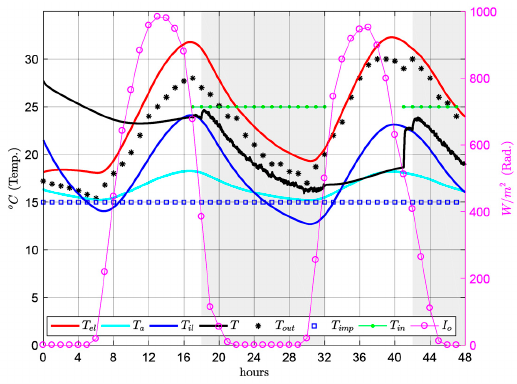
Figure 7. Case 1: Le Corbusier hypothesis. Summer. Data: calculated temperatures: T el , T a , T il , T at a height of 1.5m, outdoor temperature T out , impulse temperature T imp , inlet temperature T in , all of them against the left y -axis, and radiation I o against the right y